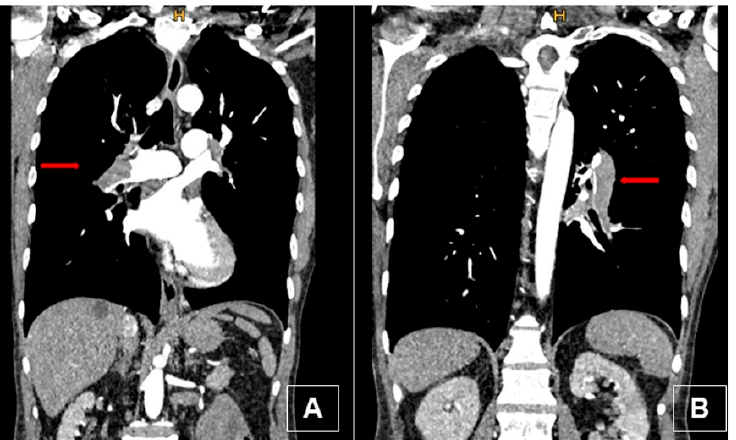
Figure 3. Preoperative computed tomography (coronal view) with intravenous contrast. ( A ) Throm- bus in the right main pulmonary artery (red arrow) with typical signs of chronic disease: thrombus adherent to the wall, bronchial artery collaterals, webs. ( B ) Thrombus in the left lower lobe pulmonary artery (red arrow).